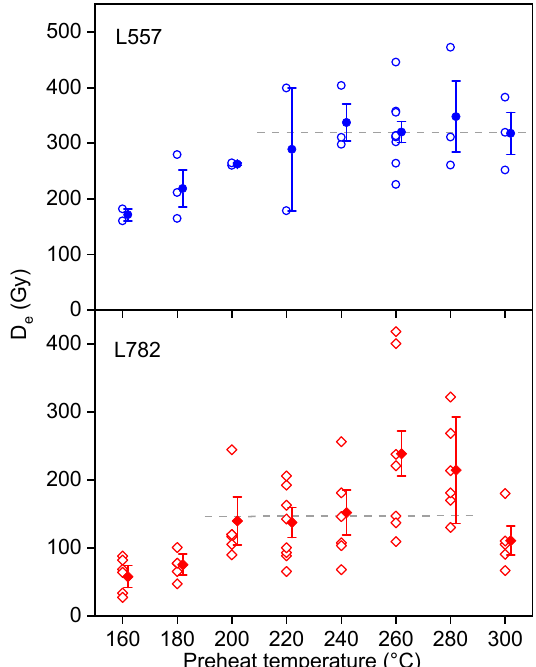
Figure 5. Dependence of De on preheat temperatures for samples L557 and L782. The open circles and diamonds represent the values of individual aliquots, and the filled circles and diamonds represent the average with their associated errors (one standard error).